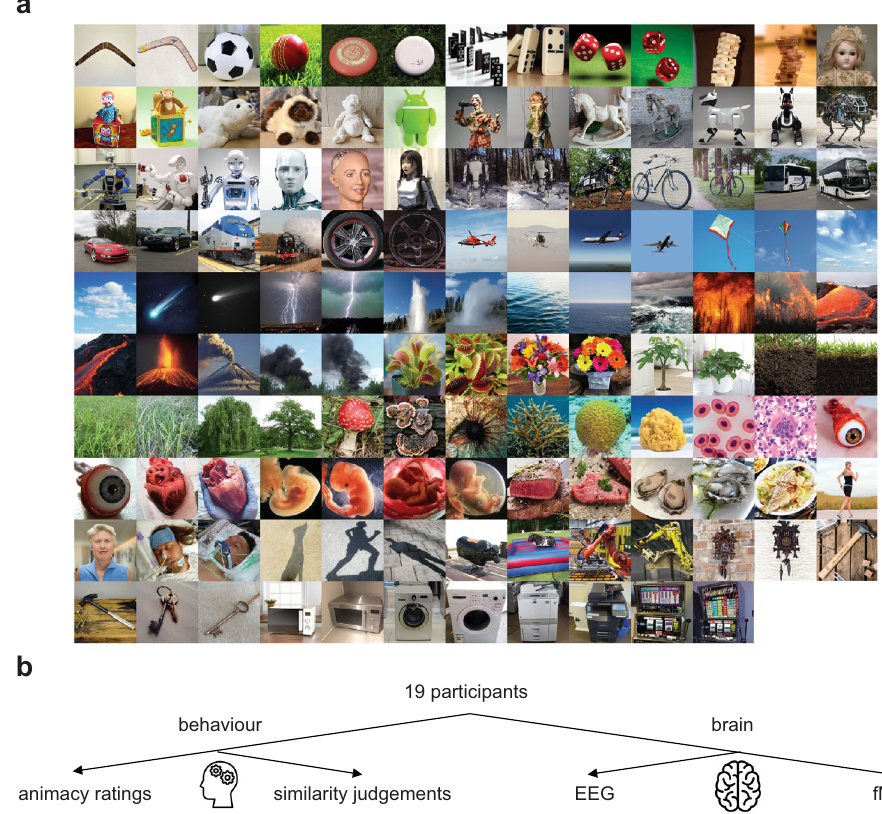
Fig. 2 Stimulus set and study overview. a The genetic-algorithm driven stimulus set consisted of 128 images decorrelated on dimensions of animacy. The stimuli were coloured images of sport equipment, games, robots, dolls and puppets, plush toys, land vehicles, air vehicles, plants, forces of nature (water, air, fi re, smoke), sea organisms, cells, organs and fetuses, humans, food, kitchen and of fi ce equipment, shadows. b Study overview. All 19 participants performed two behavioural studies: animacy ratings and similarity judgements, and two brain response measurement studies: EEG (to access temporal information) and fMRI (to access spatial information). Importantly, participants fi rst performed EEG and fMRI studies, then similarity judgements and fi nally animacy ratings. This experimental order was to ensure that participants did not know about animacy dimensions tested until the fi nal animacy